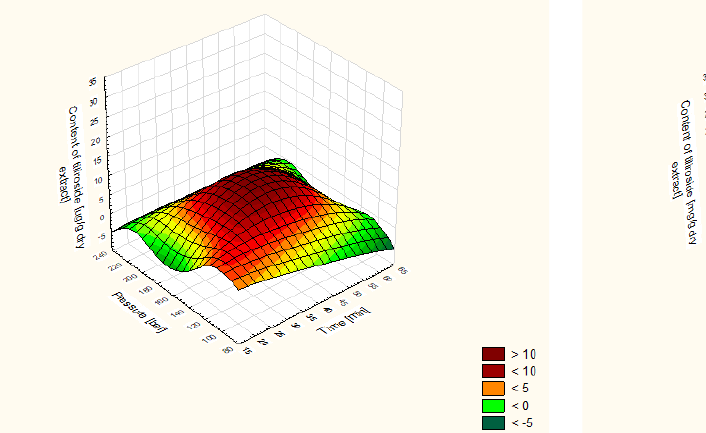
Figure 2: Surface chart 3W of the content of tiliroside vs. time and pressure of extraction (for 5% ethanol concentration) (Smoothing of smallest squares weighted by distance).